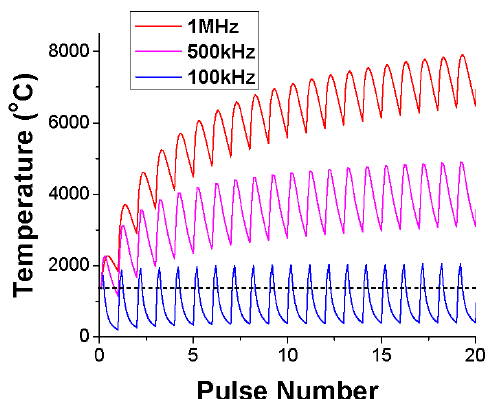
Figure 11. Finite-difference model of glass temperature versus laser exposure, at the position of 2 µm away from the center of the laser beam. Horizontal dashed line represents the 1225 °C working point of AF45 (alkali-free borosilicate) glass. Reprinted with permission from [105]. Copyright (2005), OSA.